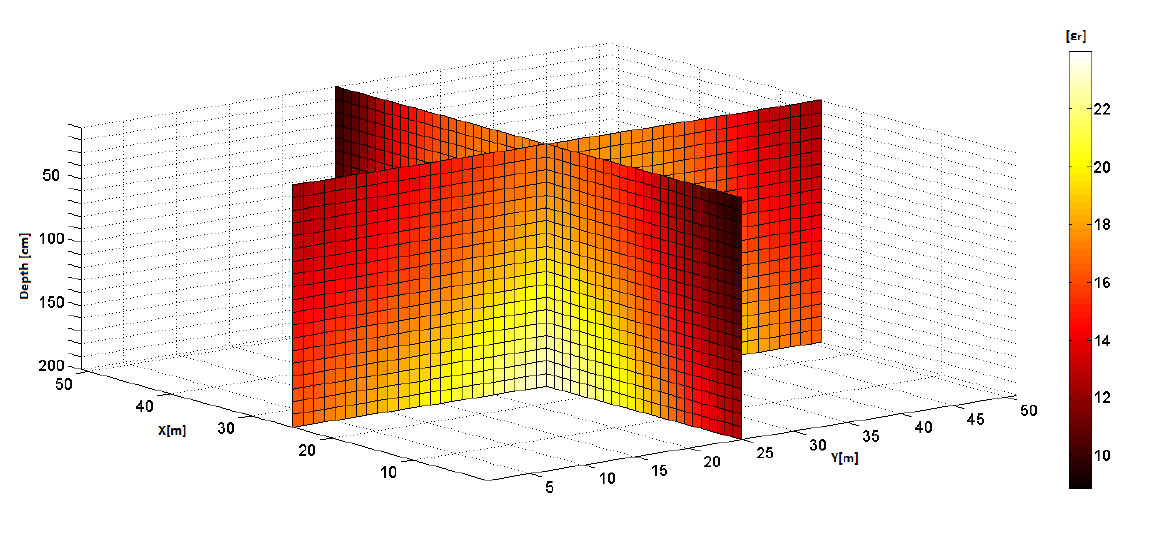
Figure 9. Relative permittivity section in silt soil textures.